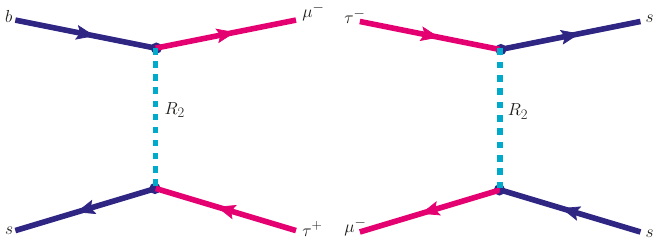
Figure 6 . Feynman diagrams for the LFV processes b → sτ + µ − (left panel), and τ → µφ ( η ( 0 ) ) (right panel) mediated through the exchange of scalar